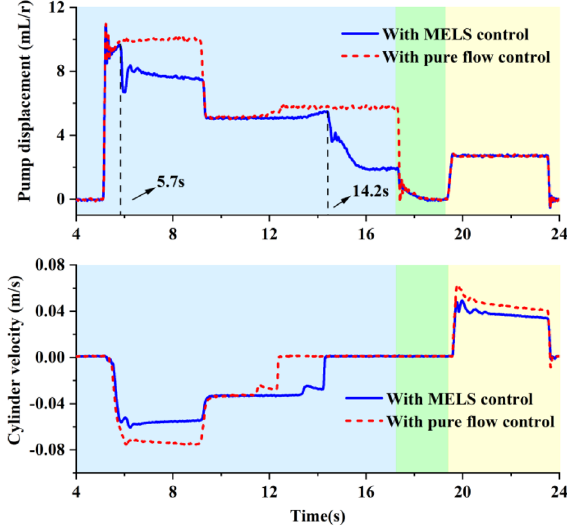
Figure 11 Pump displacement and cylinder